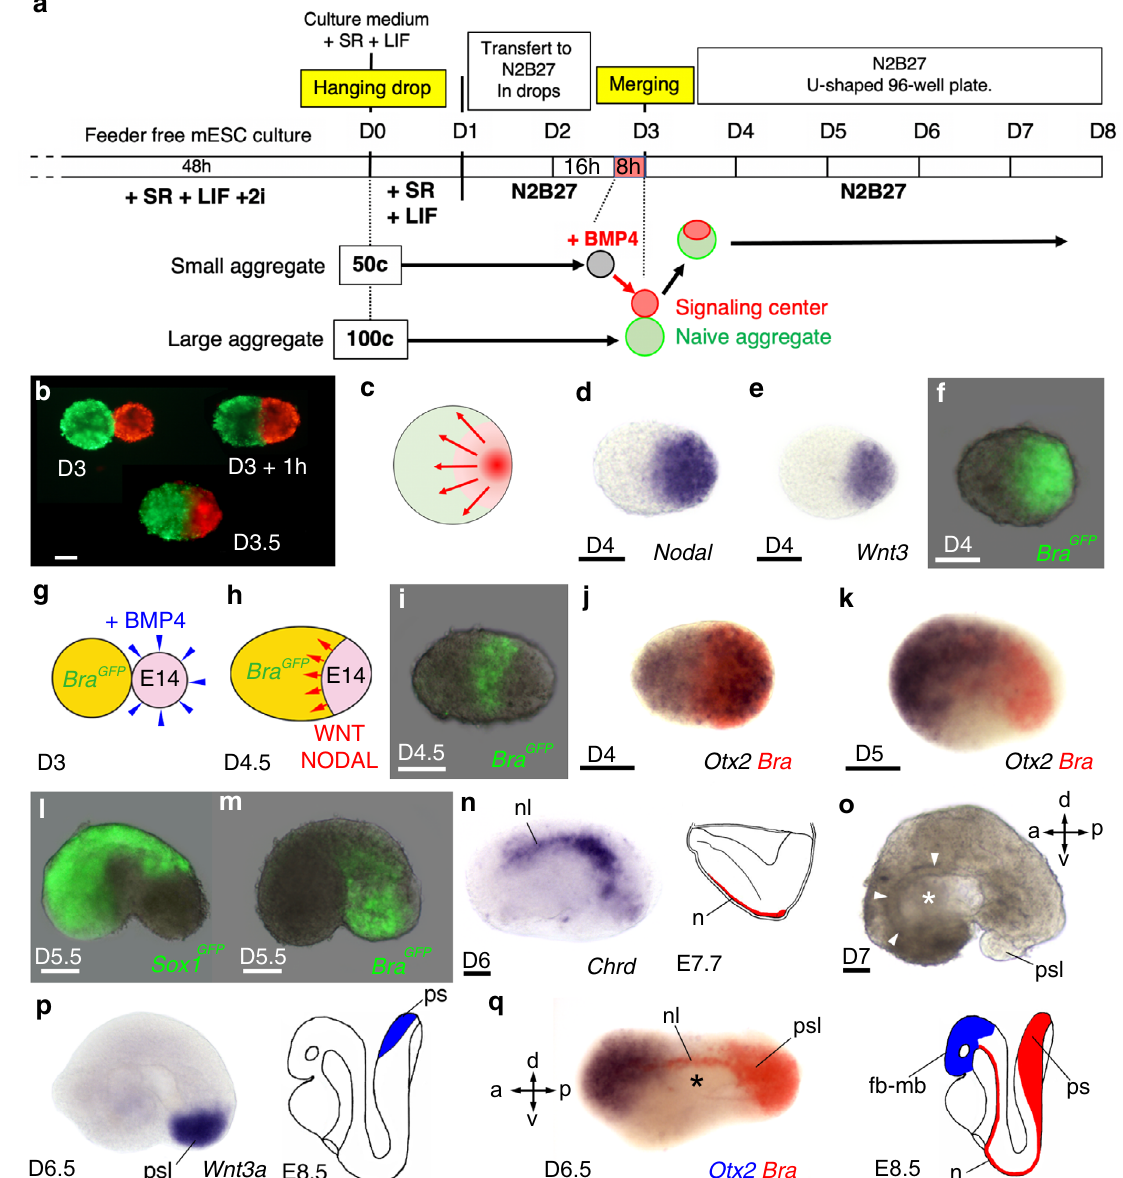
Fig. 1 Formation of embryoids by instruction of ESC aggregates with a morphogen signalling centre. a Experimental procedure (detailed in ‘ Methods ’ ) to generate embryoids by merging a large naive (untreated) ESC aggregate with a smaller aggregate in which expression of WNT3 and NODAL morphogens were induced following incubation with BMP4 protein. b A naive ESC aggregate labelled with DiO (green) placed in contact at D3 with a BMP4 instructed ESC aggregate labelled with DiI (red) had merged within 1 h and formed a spherical embryoid after 12 h. (D3.5). c Schematic summarizing the principle of instructing an ESC aggregate with a morphogen signalling centre. d , e In situ hybridization at D4 for d Nodal and e Wnt3 . f Expression at D4 of Bra GFP in an embryoid made of Bra-GFP ESC. g , h Experimental design to visualize the induction of Bra expression ( i ) in Bra-GFP ESC (naive aggregate, yellow) in response to morphogens secreted by the signalling centre (pink) made of unlabelled E14TG2 ESC. j , k Double colour in situ hybridization for Otx2 (blue) and Bra (red). l , m Expression of Sox1 GFP identifying the neurectoderm ( l ) and of Bra GFP identifying the mesoderm ( m ). n Expression of Chrd (nl: notochord- like) in a D6 embryoid, right: drawing for Chrd expression in mouse embryo at E7.7. o D7 embryoid showing a large cavity (star) lined by an epithelium (arrows). p Expression at D6.5 of Wnt3a in a posterior primitive streak-like structure (psl) and in mouse at E8.5 (cartoon). q Double colour in situ hybridization showing expression of Otx2 (blue) anteriorly, of Bra (red) posteriorly and in notochord-like structure extending on top of a ventral cavity (star) in an embryoid at D6.5. Cartoon showing expression of Bra and Otx2 in the mouse embryo at E8.5 (fb-mb: forebrain-midbrain, n: notochord, ps: primitive streak). a: anterior, p: posterior, d: dorsal, v: ventral. Staging of embryoids (D: day) indicated for each panel. Numbers of performed experiments and of biological samples analysed is provided in ‘ Statistics and reproducibility ’ in the Methods section. Variability in genes expression is provided in Supplementary Fig. 4. Scale bars: 100 µ